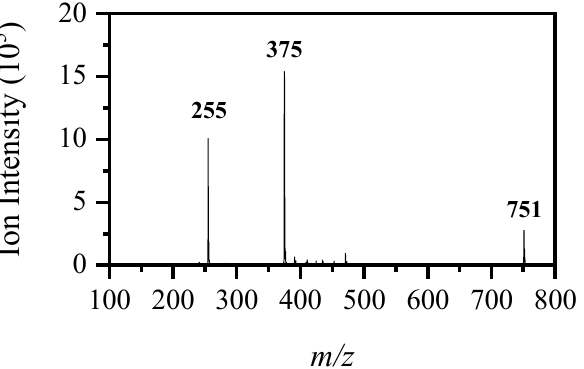
Figure 1. Negative-ion-mode ESI mass spectrum of deprotonated riboflavin ([RF − H] − ). Laser-interfaced mass spectrometry (LIMS) was used to characterise the wavelength- dependent photoabsorption and photofragmentation properties of [RF − H] − in vacuo. The spectra are acquired by action spectroscopy, as described in Section 4 and in References